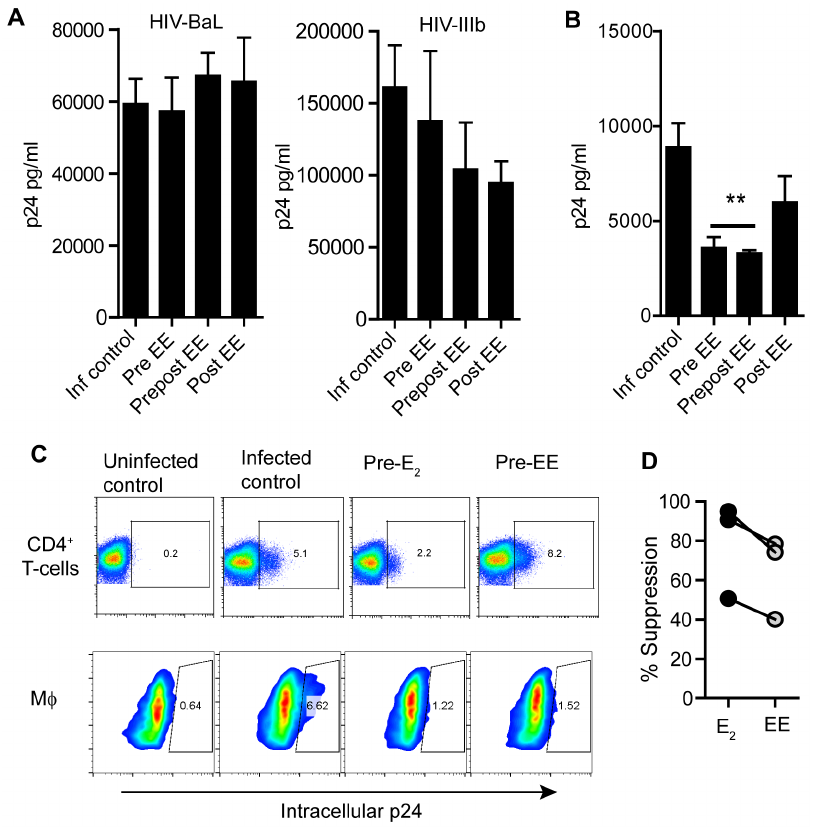
Figure 3. Effect of EE on HIV-infection of CD4 + T-cells and macrophages. A) Released p24 levels in the culture media after 7 days of infection when CD4 + T-cells where pre-treated with EE (pre EE), treated with EE before and after infection (prepost EE) or only after infection (post EE). Bars represent mean 6 SEM from 4 independent experiments with different donors. B) Released p24 levels in the culture media after 7 days of infection when macrophages where pre-treated with EE (pre EE), treated with EE before and after infection (prepost EE) or only after infection (post EE). Bars represent mean 6 SEM from 4 independent experiments with different donors. **P , 0.01. C) Comparison between CD4 + T-cells and macrophages from the same donors pre-treated with E 2 and EE. Dot plots represent percent of p24 + cells. D) Percent of suppression of HIV-infection respect to infected control in macrophages from the same donors pre-treated with E 2 (black dots) or EE (grey dots) in parallel. Each dot represents one individual.